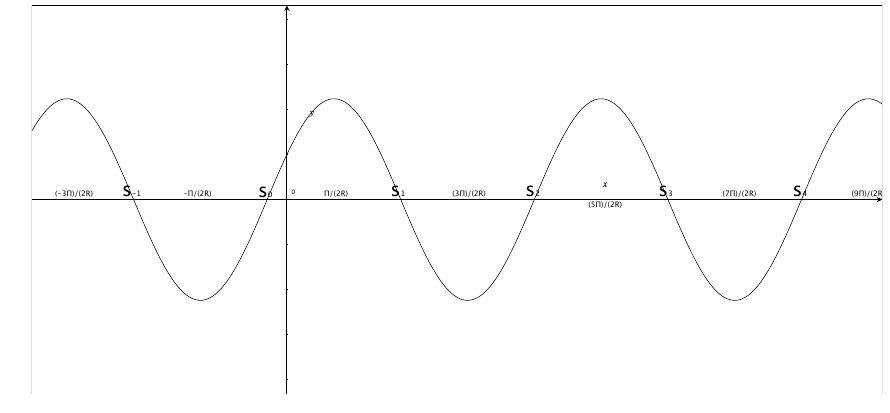
Figure A2. Graph of the function ϕ for R = 1 and N = −